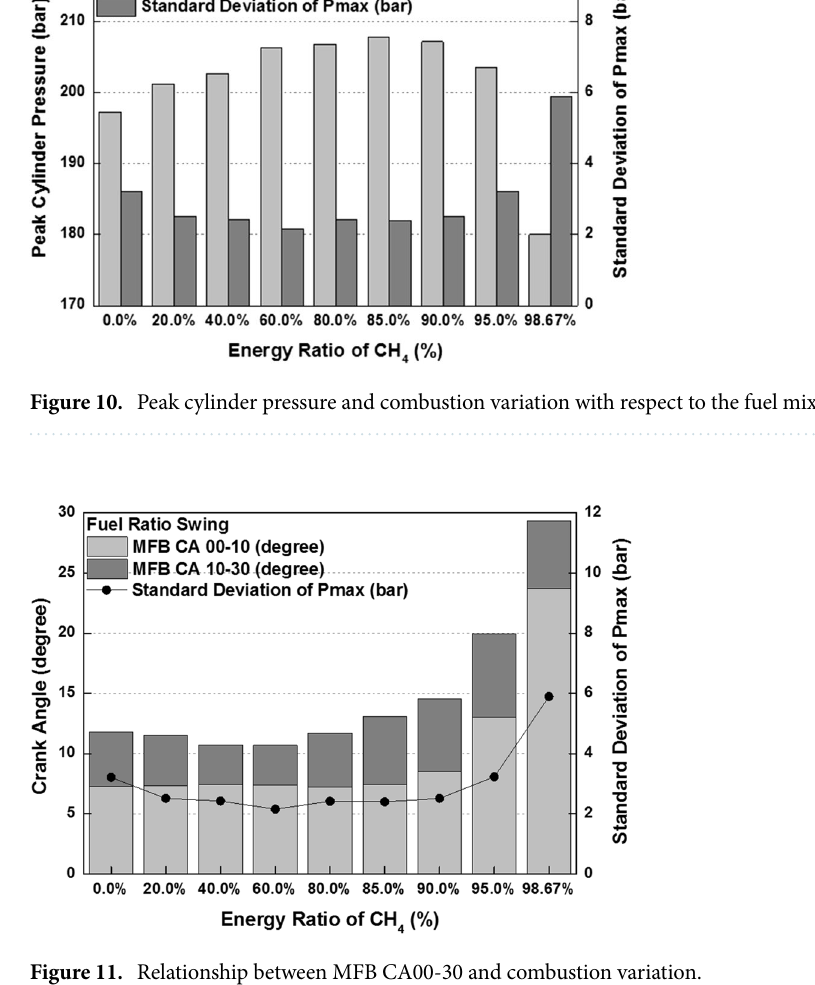
Figure 11. Relationship between MFB CA00-30 and combustion